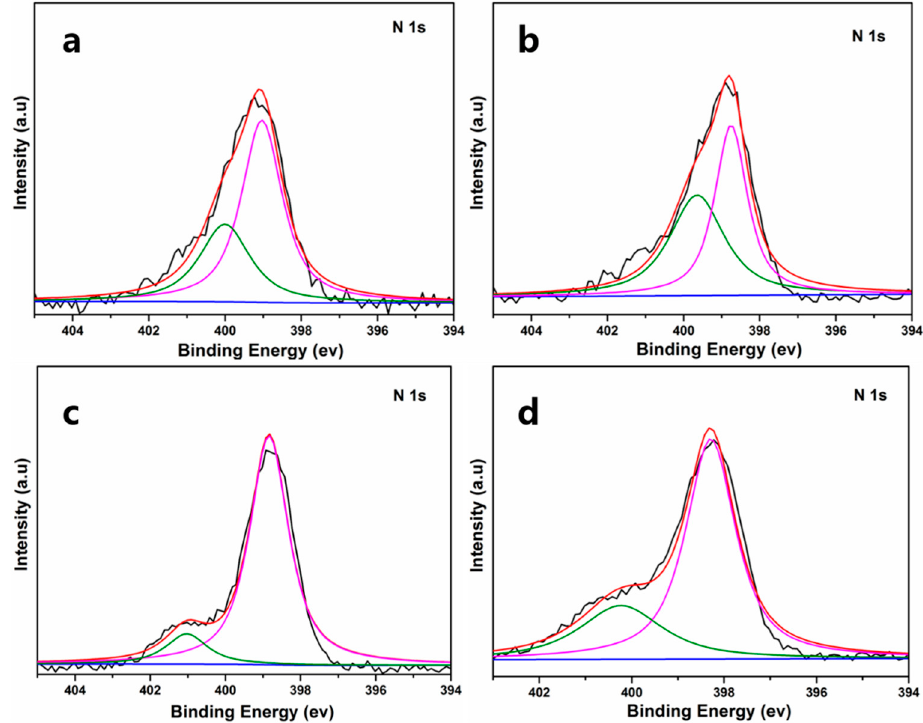
Figure 8. XPS spectra of the N 1s region for ( a ) GO-0, ( b ) GO-0.5, ( c ) GO-1.0 and ( d ) GO-1.5. Table 6. The area ratio of A399.5 and A400.8. Samples